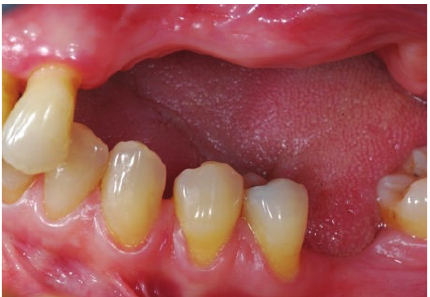
Figure 1: Clinical view of the left upper maxilla atrophic